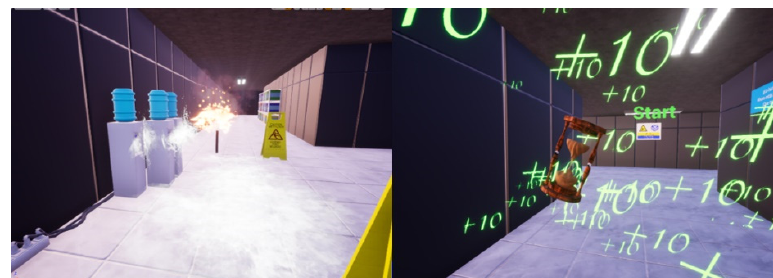
Figure 7. Solution for particle effects using Cascade.